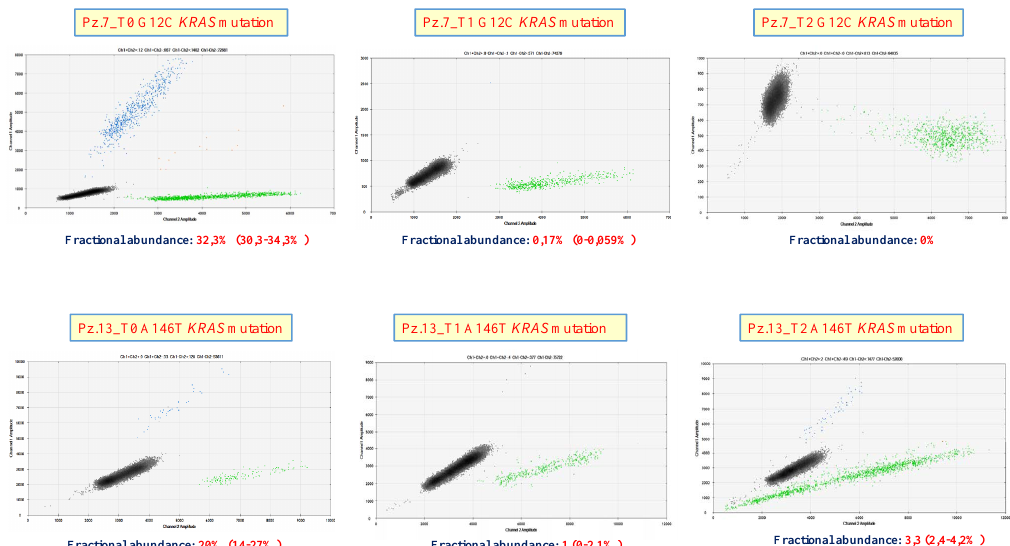
Figure 5 Figure 5. Droplet digital PCR analysis. Examples of ddPCR plot for two metastatic colorectal cancer